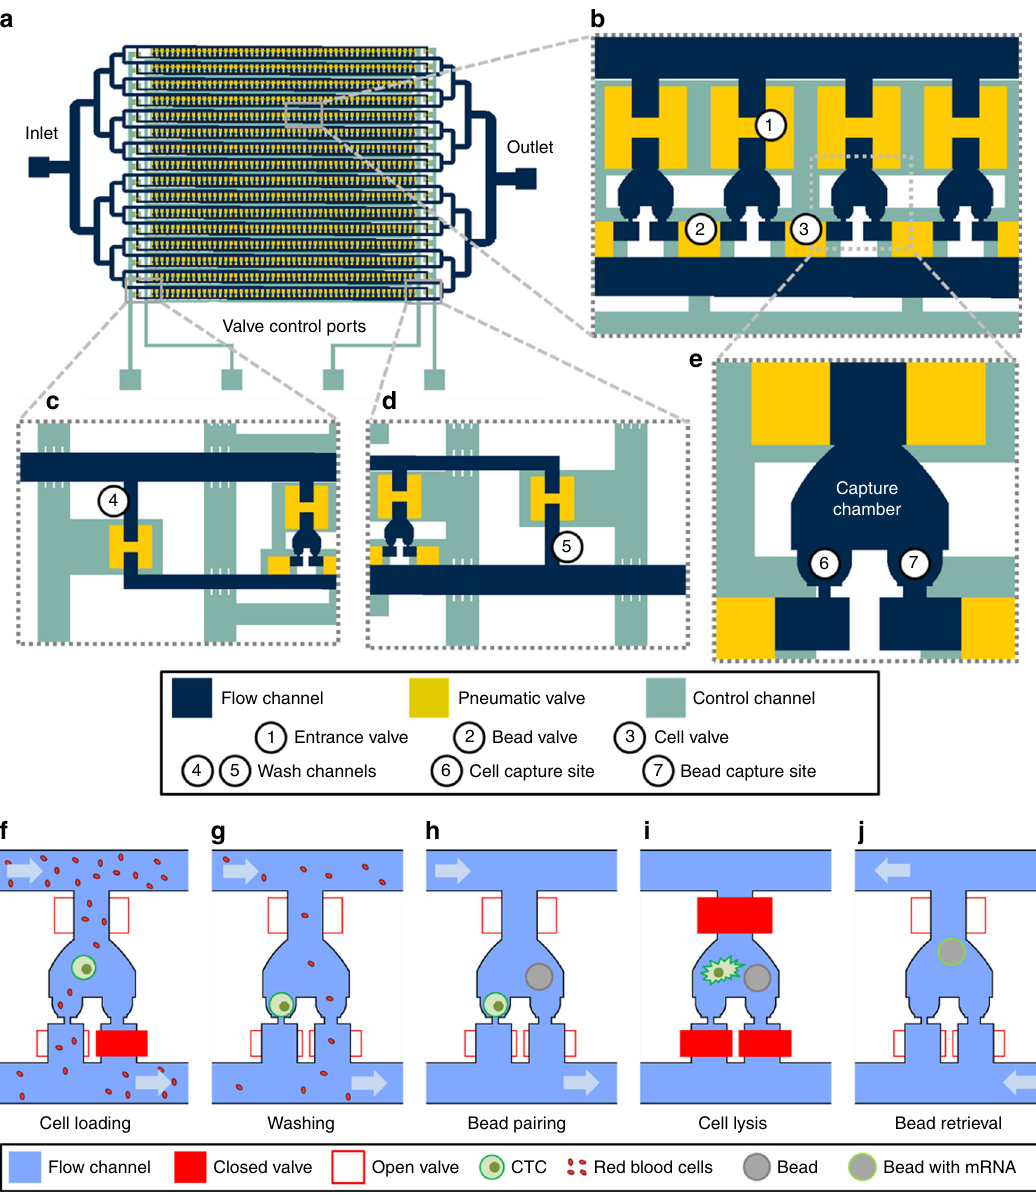
Fig. 1 Hydro-Seq, a high capture ef fi ciency scRNA-seq platform for contaminated rare samples. a – e Design of Hydro-Seq technology.